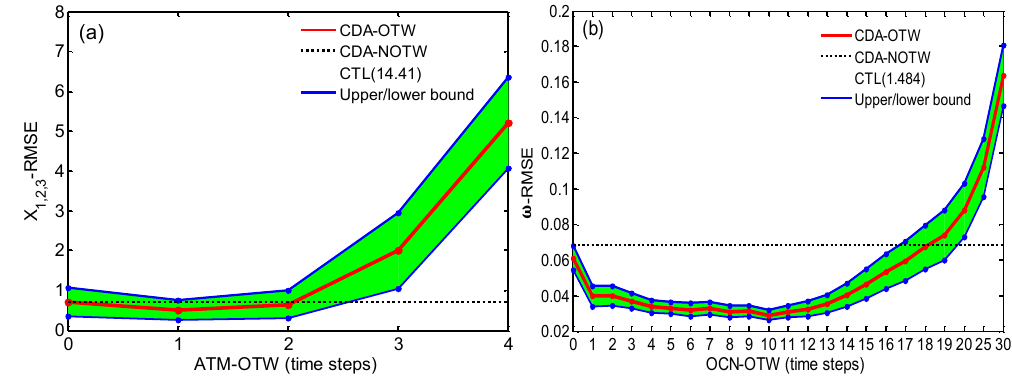
Figure 7. Same as Fig. 4 but using a multi-variate adjustment scheme. In panel (b) the optimal ATM-OTW is also set as